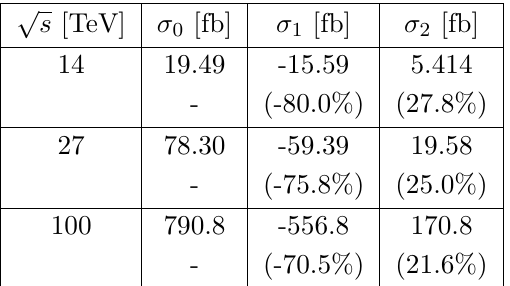
Table 1 . LO contributions to (cid:27) pheno . We show for every entry the ratio with (cid:27) 0 at the same energy. NLO p s [TeV]